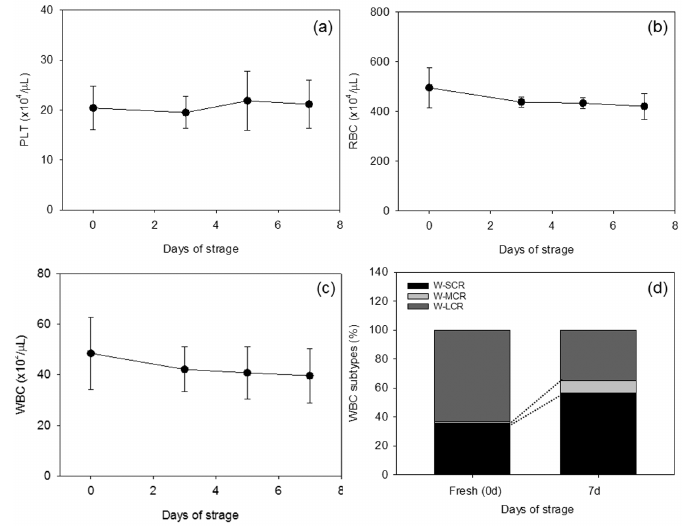
Figure 1. ( a – c ) Stable counts of platelets, red blood cells (RBCs), and white blood cells (WBCs) in stored whole blood samples ( n = 8); ( d ) A comparison of WBC components between fresh and 7-day-stored WB samples. The data were calculated from an average of 8 samples. W-SCR: WBC small cell ratio, W-MCR: WBC middle cell ratio, W-LCR: WBC large cell